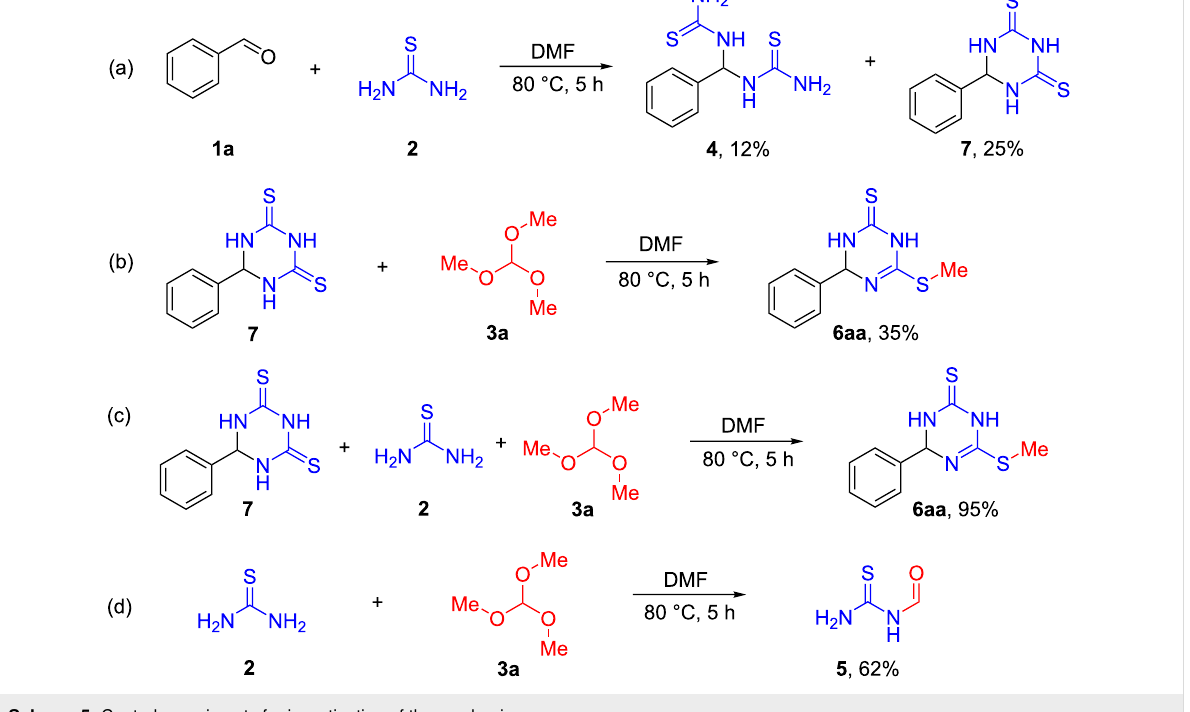
Scheme 5: Control experiments for investigation of the mechanism.